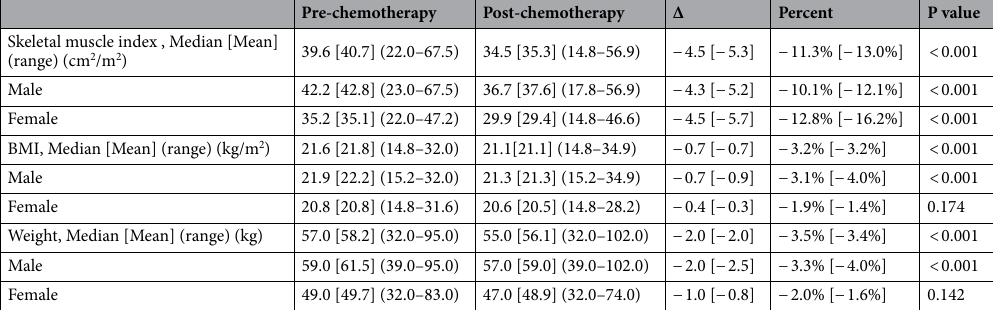
Weight, Median [Mean] (range)